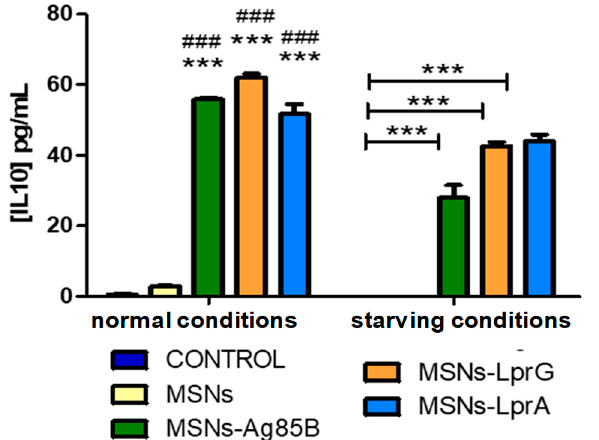
Figure 7. IL-10 levels after exposure of RAW 264.7 cells to 10 µ g / mL of MSNs, MSNs-Ag85B, MSNs-LprG, and MSNs-LprA for 24 h ( n = 3). IL-10 was not detected in cells treated with LPS. Data were evaluated by ANOVA followed by Bonferroni’s multiple-comparison test. *** p < 0.001 versus control; ### p < 0.001 versus MSNs treated cells.